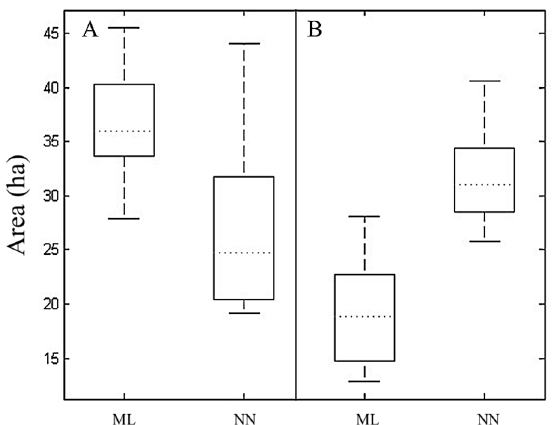
Figure 5. Area (Ha) calculated with Maximum Likelihood Algorithm (ML) and the neural network (NN) for the image from 2004 ( A ) and in 2011 ( B ).